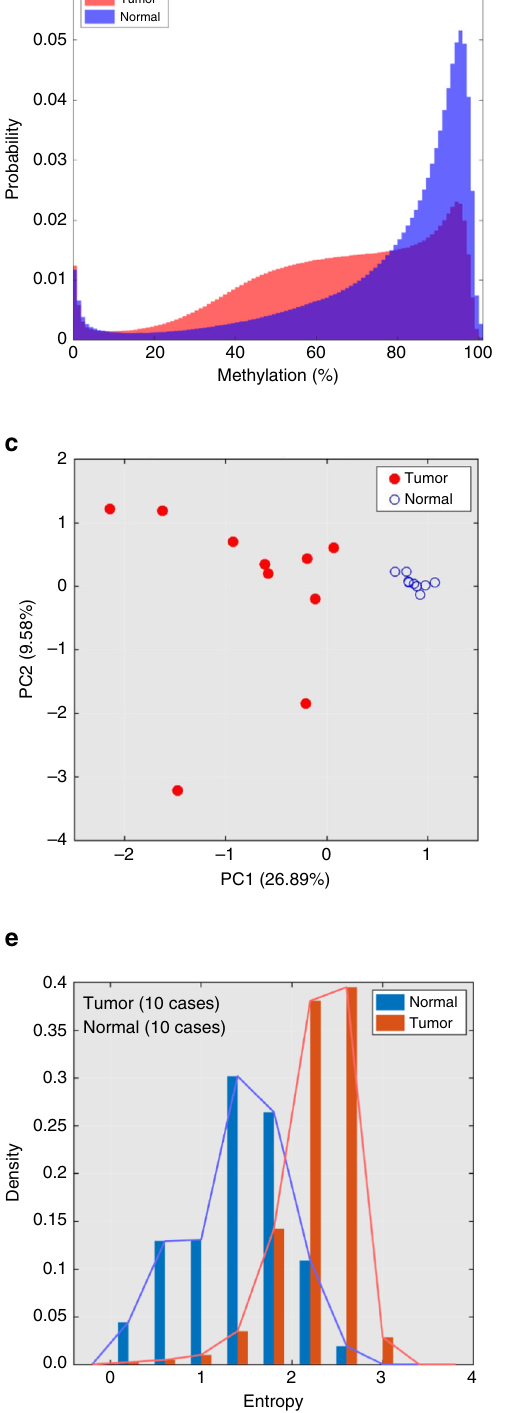
variance of methylation level along with other clinical variables (age, gender, alcohol usage) for multivariate Cox regression analysis. Although heavy alcohol intake is a known risk factor in ESCC development 18 , we observed a trend toward to inferior overall survival time in patients with alcohol consumption but no impact on methylation variance: only three DMC probes associated with alcohol users (log 2 (FC) ≥ 0.2 and FDR < 0.05)